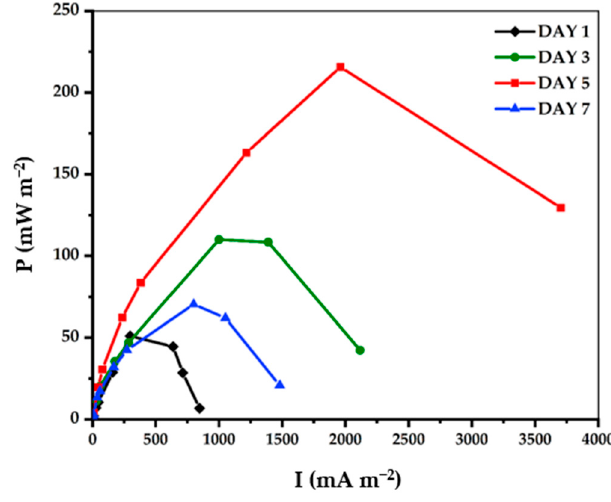
Figure 7. Power density variation of Li 0.95 Ta 0.76 Nb 0.19 Mg 0.15 O 3 versus time under light conditions.